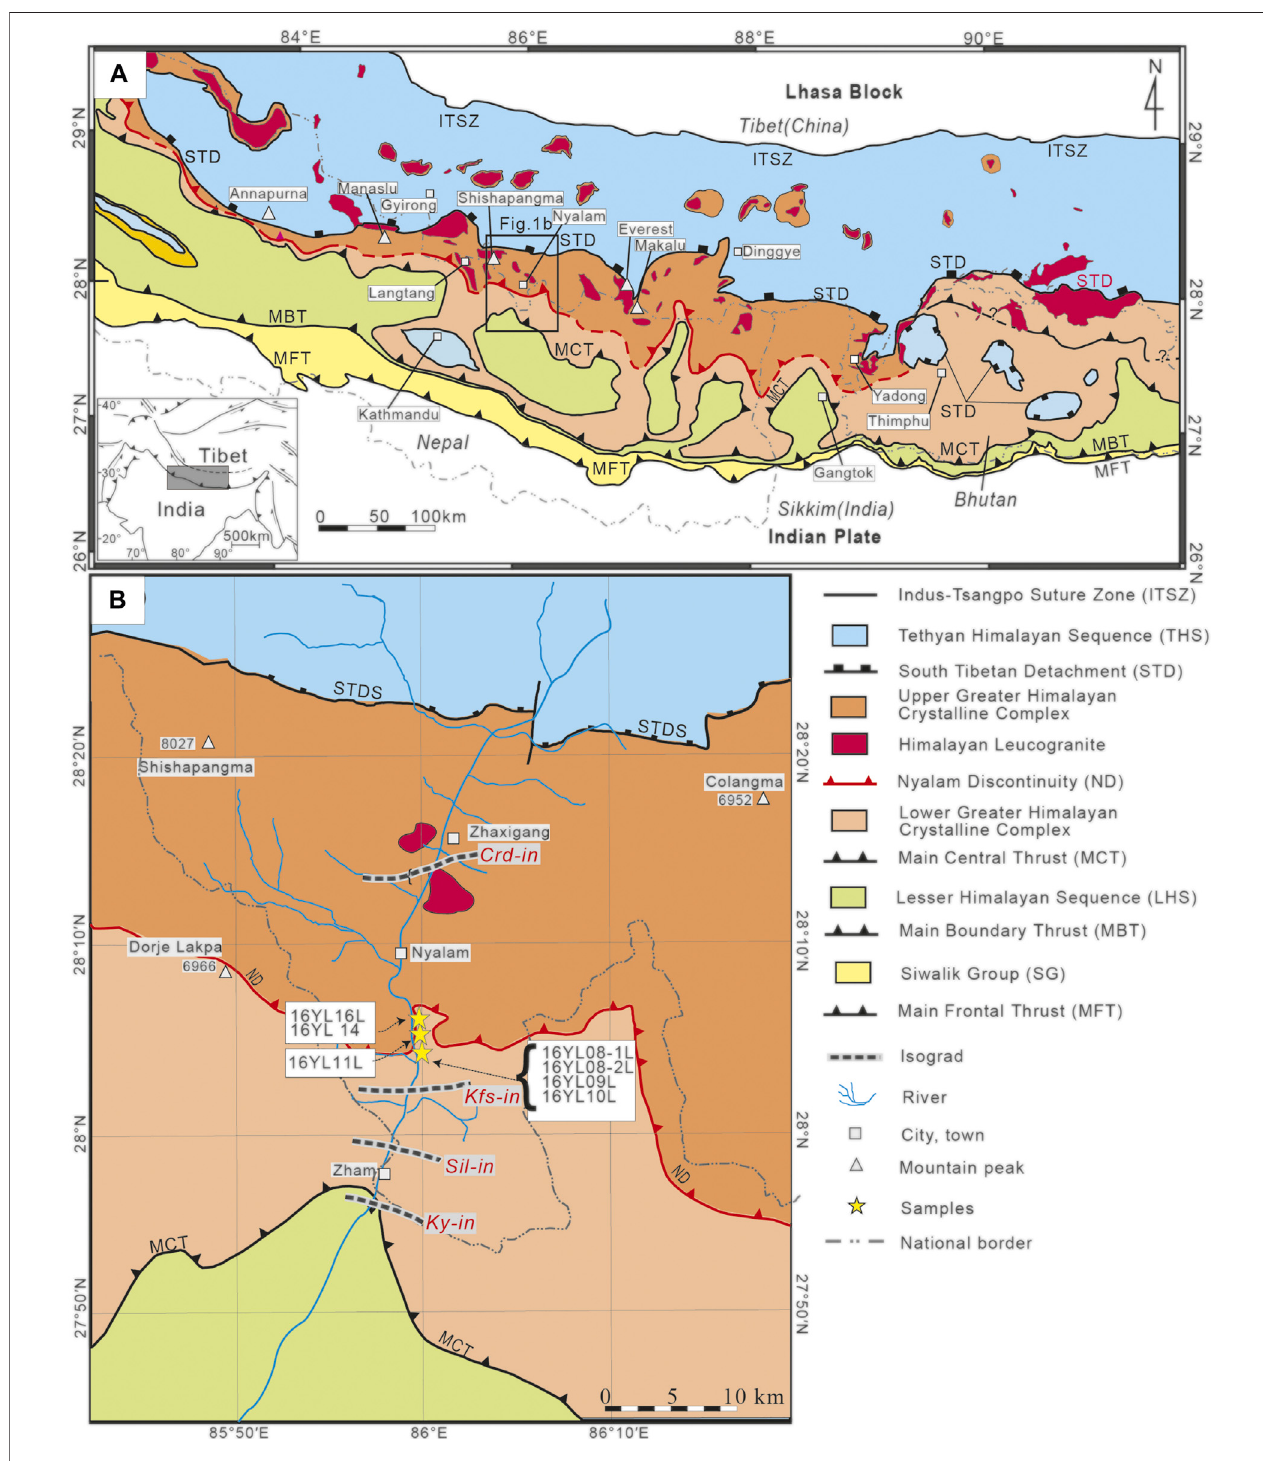
FIGURE 2 | (A) Simpli fi ed geological map showing the tectonic framework of the Himalayan orogenic belt. The rectangle indicates the location of the Nyalam. (B) Geological sketch map of the Nyalam region (modi fi ed after Wang et al., 2015). Mineral abbreviations follow Whitney and Evans (2010). and 143 Nd/ 144 Nd isotopic ratios (Clemens et al., 2017). Therefore, correlation of the Nd-Hf isotopes that should lie in the Terrestrial Array (Vervoort et al., 2011). Nearly all terrestrial rocks from the Sr-Nd-Hf isotopes are usually coupled in the crustal rocks. various sources commonly negative correlates between 87 Sr/ 86 Sr The occurrence of isotopic signatures that deviate from this